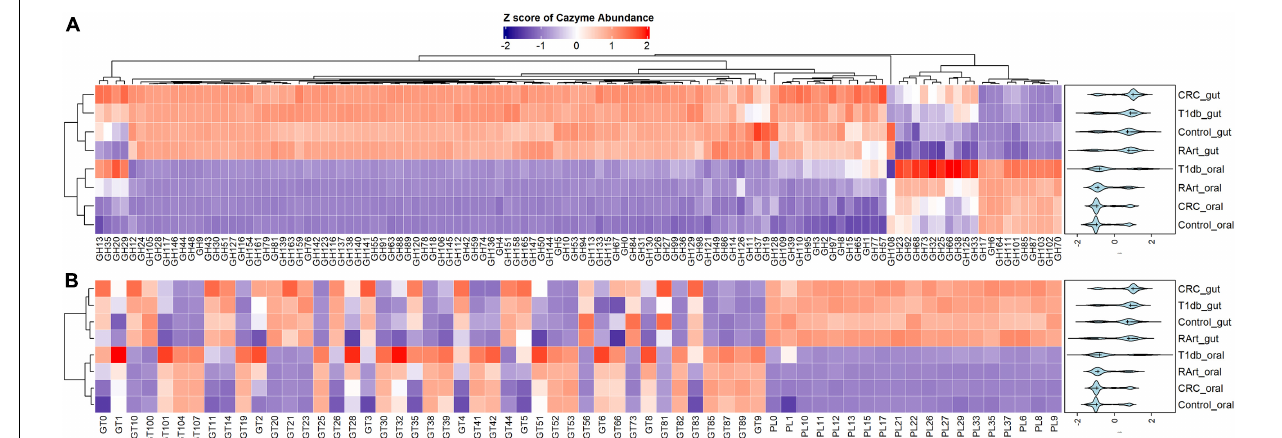
FIGURE 5 | A heatmap of CAZyme family distribution in saliva (oral) and fecal (gut) samples of 935 metagenomes derived from healthy controls and patients with type 1 diabetes, colorectal cancer, and rheumatoid arthritis. A total of 178 distinct CAZymes; 116 glycosylhydrolases (GHs) (A) , 19 polysaccharide lyases (PLs), and 43 glycosyltransferases (GTs) (B) from nine phyla and 86 genera are represented. The oral and gut ecosystems show distinct profiles revealing a more extensive carbohydrate metabolism in the gut. CRC, colorectal cancer; T1db, type 1 diabetes; RArt, rheumatoid arthritis. The legend shows the Z scores of the mean log-transformed CAZyme family